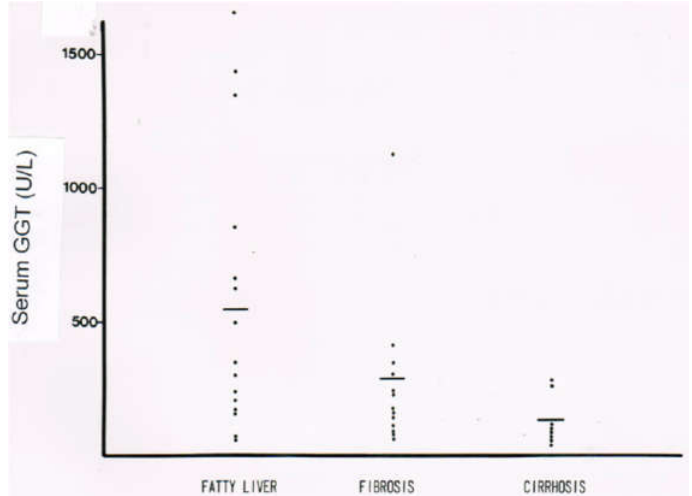
Figure 15. Serum gamma‐glutamyltransferase (GGT) activities in patients with different stages of alcoholic liver diseases. Highest GGT activities were found in patients with alcoholic fatty liver, with decreasing values along with increasing fibrosis. Relative low values are found in patients with alcoholic cirrhosis, possibly due to reduced GGT enzyme induction because of impaired liver function.